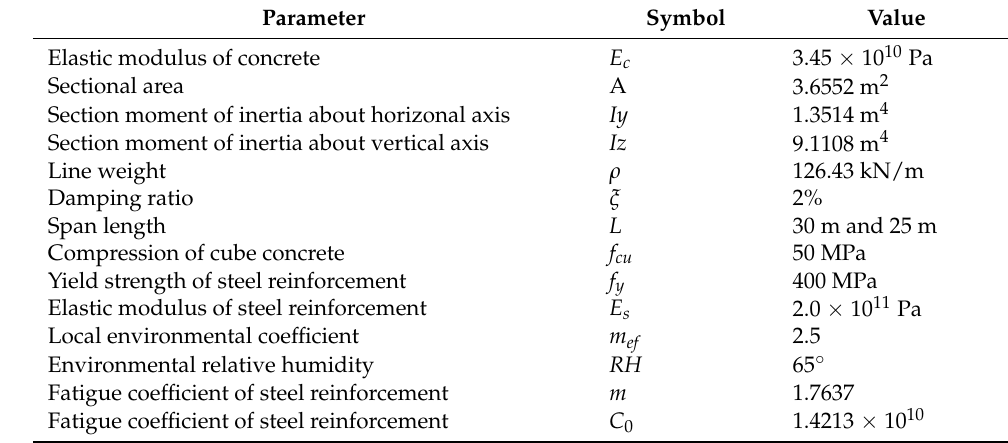
Table 1. Parameters of bridge [27].